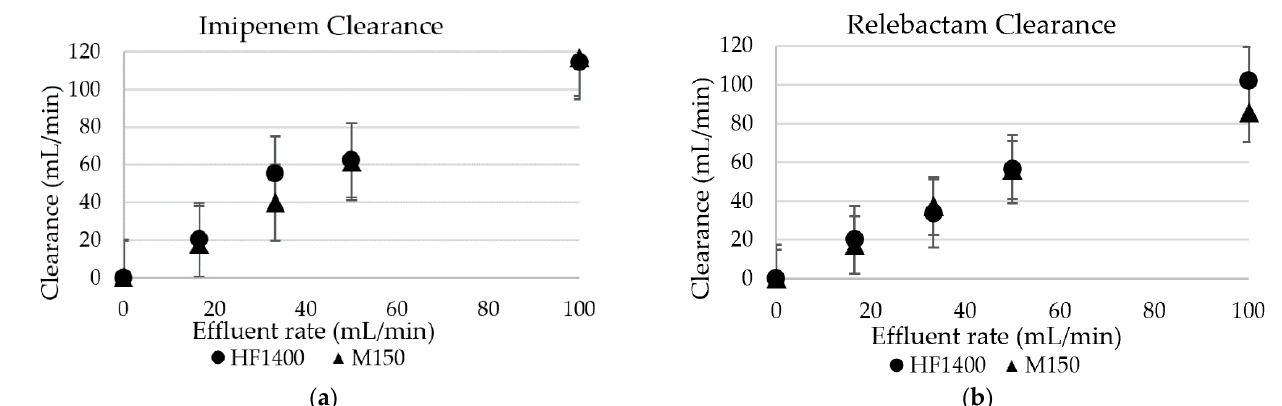
Figure 2. ( a ) Imipenem continuous hemodialysis transmembrane clearance; ( b ) Relebactam continuous hemodialysis transmembrane clearance. Table 2. Demographic and Pharmacokinetic Parameters Used in Monte Carlo Simulations.